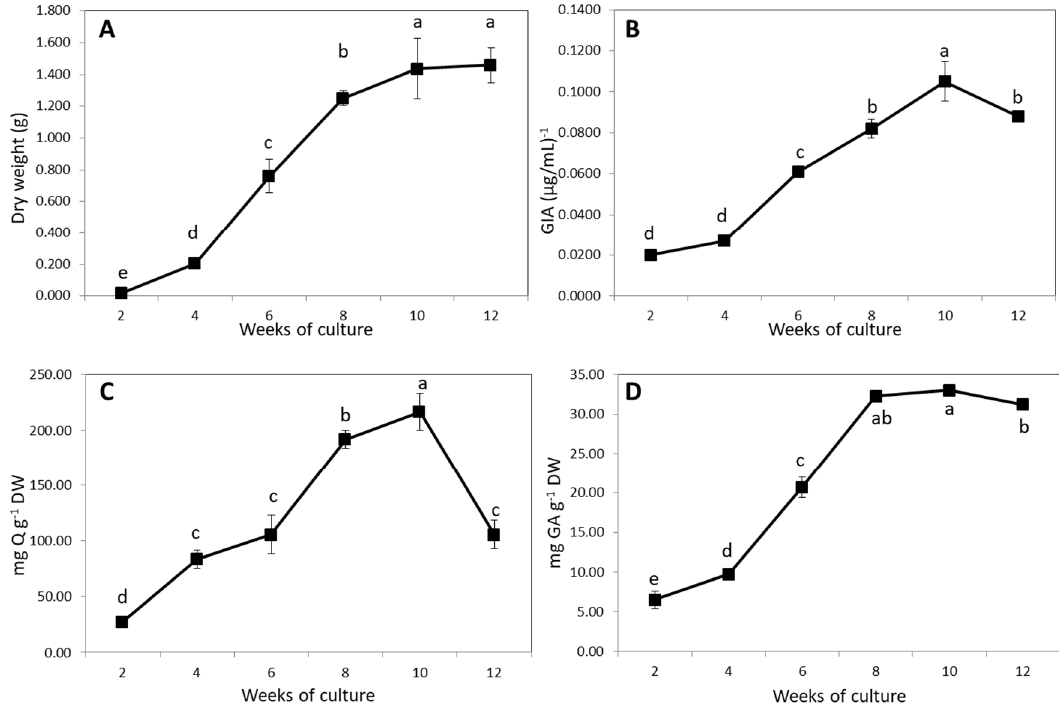
Figure 4. Kinetics of growth. ( A ), GIA ( B ), PHEL ( C ) and FLA ( D ) of Urena lobata AHRs cultured for 12 weeks. Each value in the curve represents the average of three independent cultures; error bars represent standard deviations. The values in a line marked with different lower-case letters denote significant differences between samples at p < 0.05 (Duncan’s multiple range test).